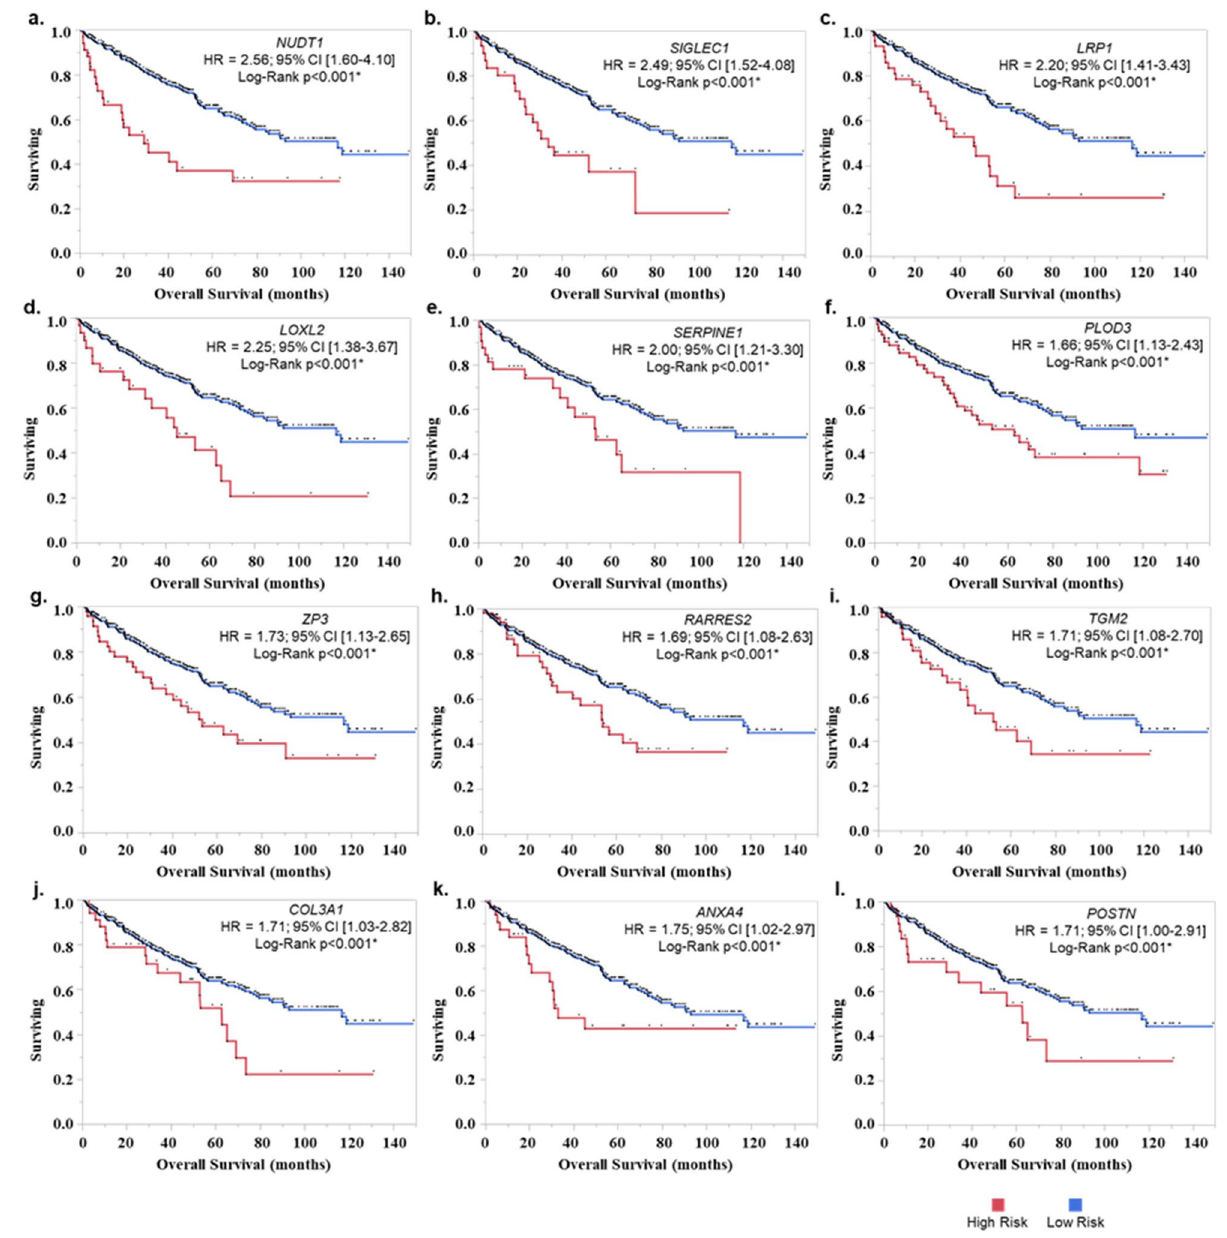
Figure 3. KM analysis of ECM genes with higher expression (z > 2 score) in RCC patients. ( a ) NUDT1 , ( b ) SIGLEC1 , ( c ) LRP1 , ( d ) LOXL2 , ( e ) SERPINE1 , ( f ) PLOD3 , ( g ) ZP3 , ( h ) RARRES2 , ( i ) TGM2 , ( j ) COL3A1 , ( k ) ANXA4 , and ( l ) POSTN . The patients with higher expression (cutoff: z-score > 2) were grouped in high risk and other patients were in the low-risk